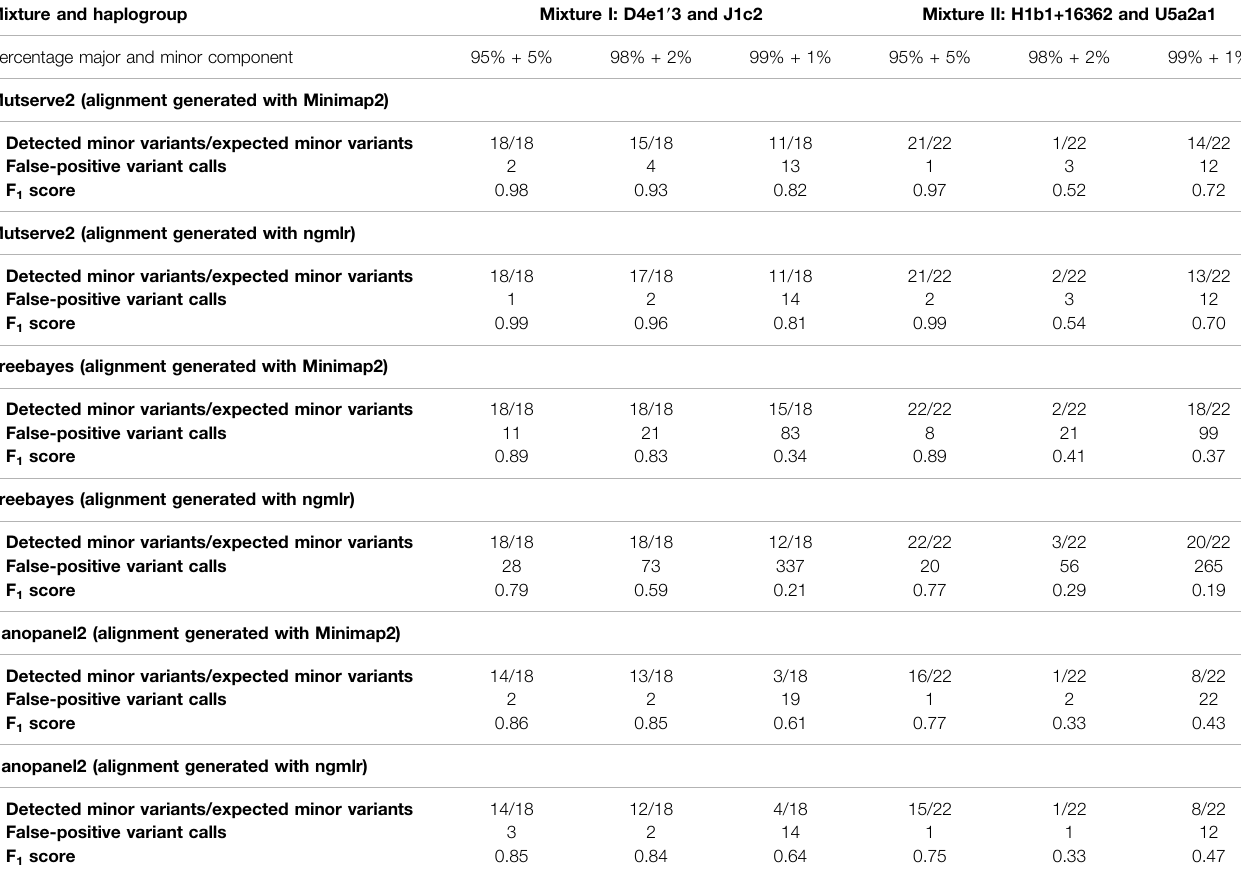
TABLE 1 | Summary of detected minor variants, false-positive calls, and F1 scores resulting from the three tested variants callers. Mixture and